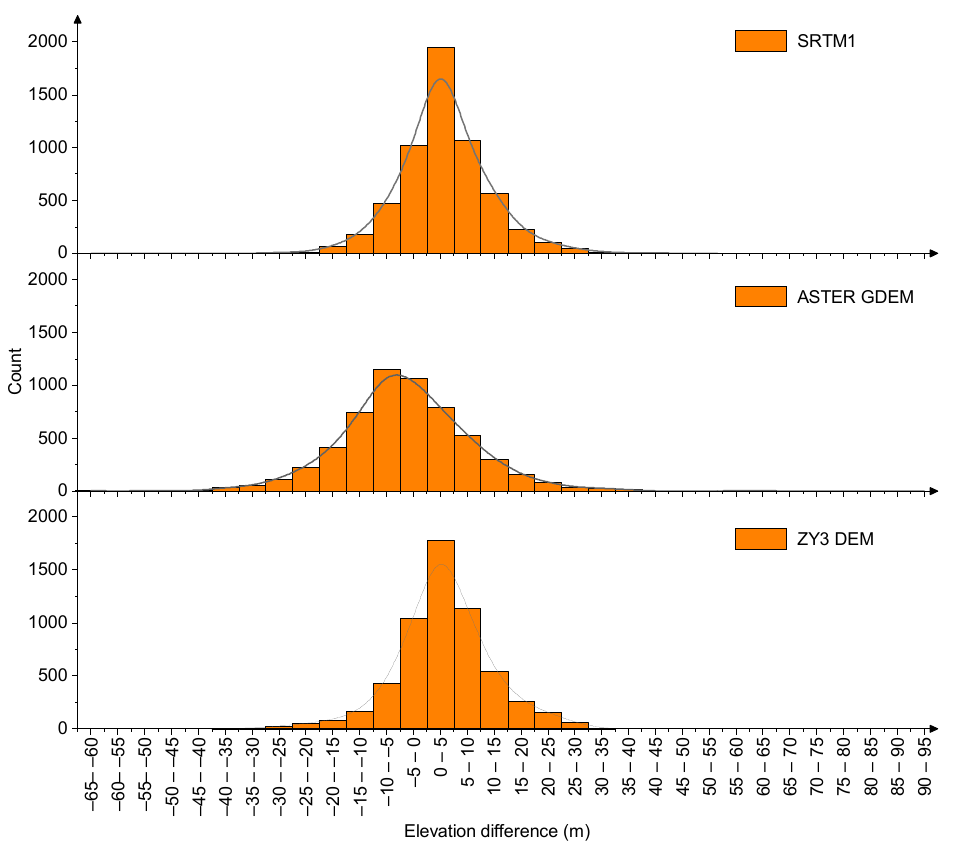
Figure 8. Elevation difference for these three DEMs. Table 4. Statistics of the vertical error values as compared with 1:50,000